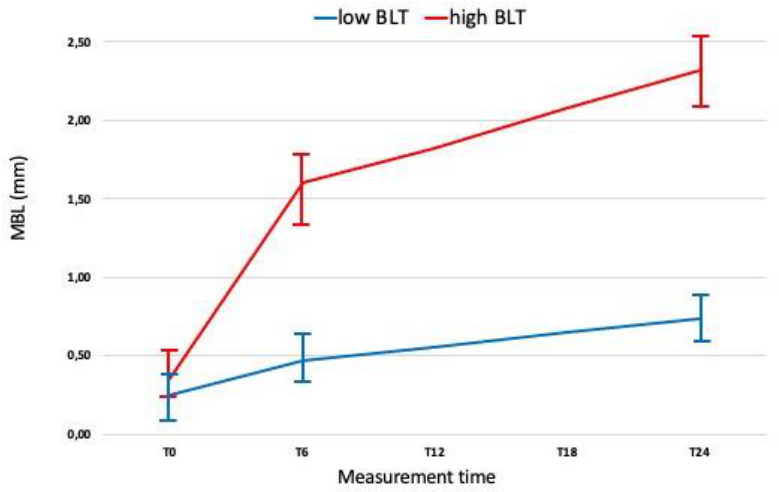
Figure 2. Marginal bone loss values as a function of time. Healing time (T0 = 6 months from surgery— restoration delivery); T6 and T24 were measured at 6 and 24 months after functional loading.